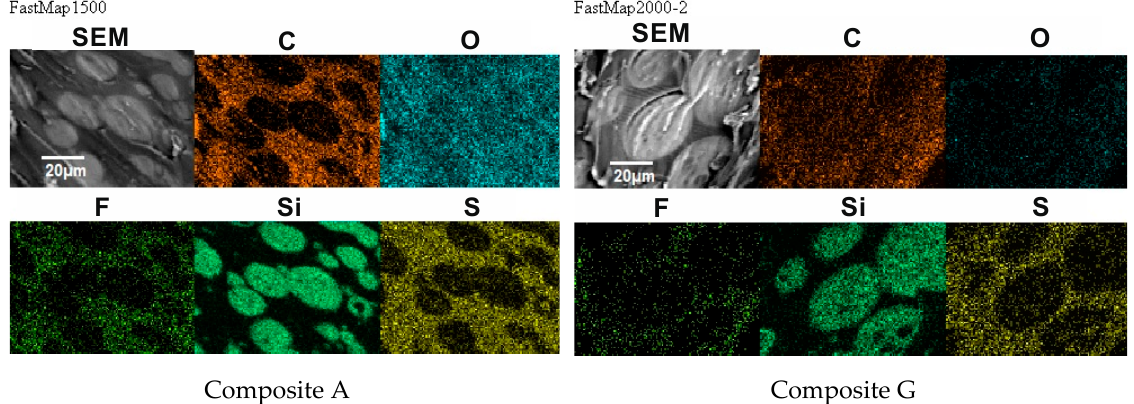
Figure 10. Morphology of the composite film prepared using EC/DMC as solvent ( Composite A ), and the composite film where that solvent was replaced with reactive IL 3 ( Composite G ).